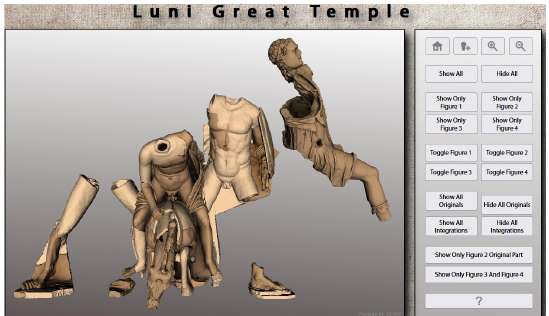
Figure 3 . Luni Great Temple’s 3DHOP Sample Viewer. Right tab’s buttons allow selective visualization of single sculptures.